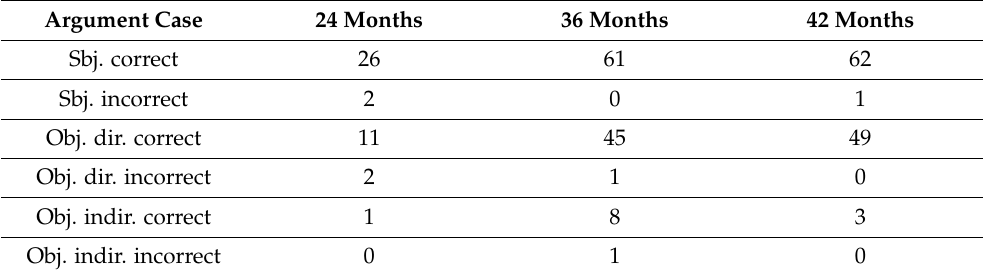
Table 14. Argument case